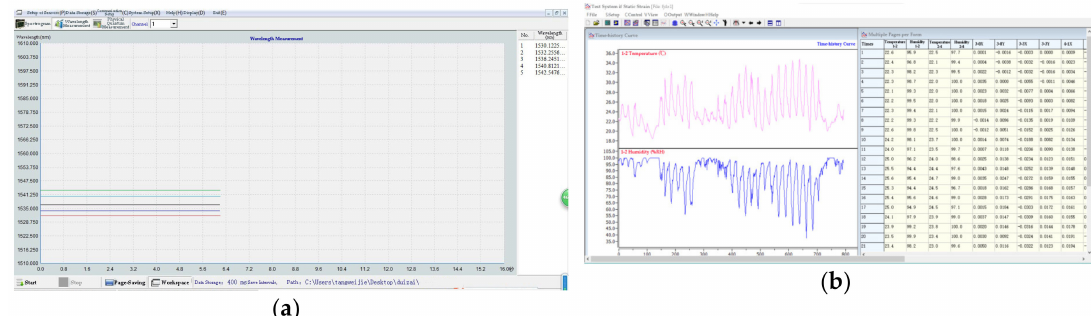
Figure 6. Data processing and control software: ( a ) Optical Sensor Analysis (OSA) software; ( b ) Yangzhou Jingming data acquisition software.